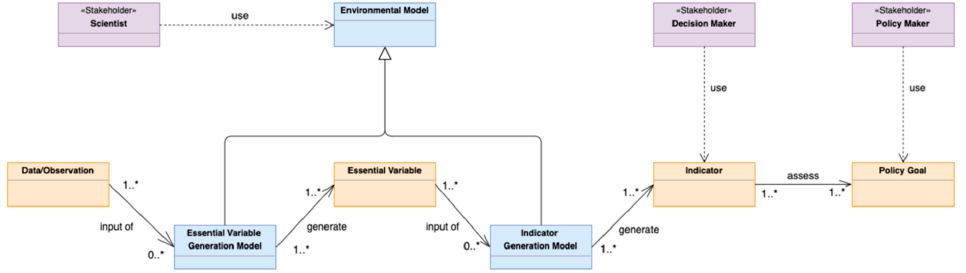
Figure 3. Data To Knowledge for Policy Conceptual Model. Figure 3 captures possible entry-points for different stakeholder types: •